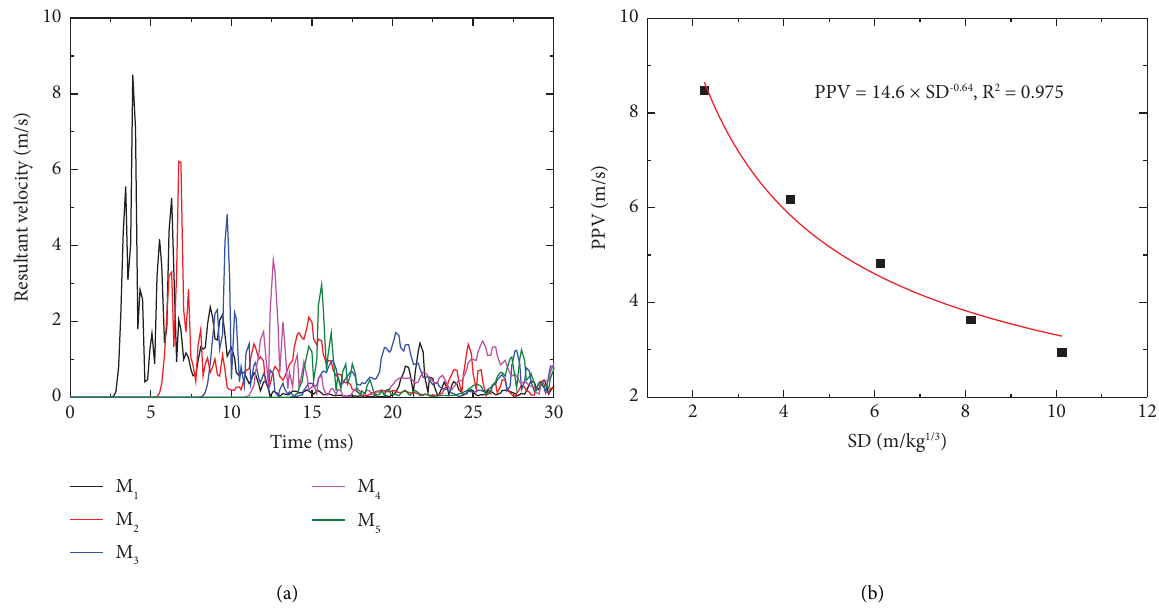
Figure 3: Resultant velocity time histories and PPV of ground vibration induced by blasting without vibration-isolating slot. (a) Resultant velocity time histories. (b)